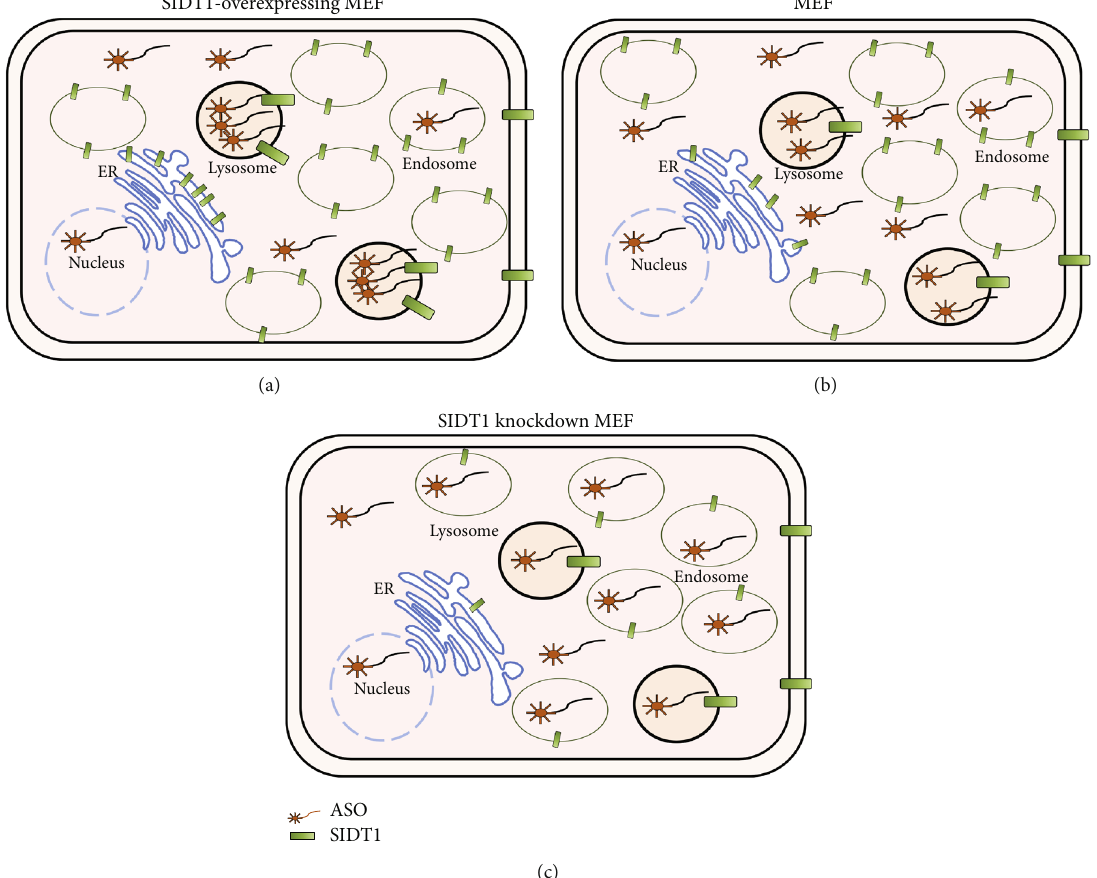
Figure 7: Aberrant levels of SIDT1 suppress the naked ASO e ff ect. SIDT1-overexpressing (a), normal (b), and SIDT1 knockdown (c) MEFs are shown. The numbers of ASO, SIDT1, and SIDT2 molecules re fl ect relative amounts among in those cells, and only the ASO molecules in the cytosol and the nucleosol are supposed to exert the antisense e ff